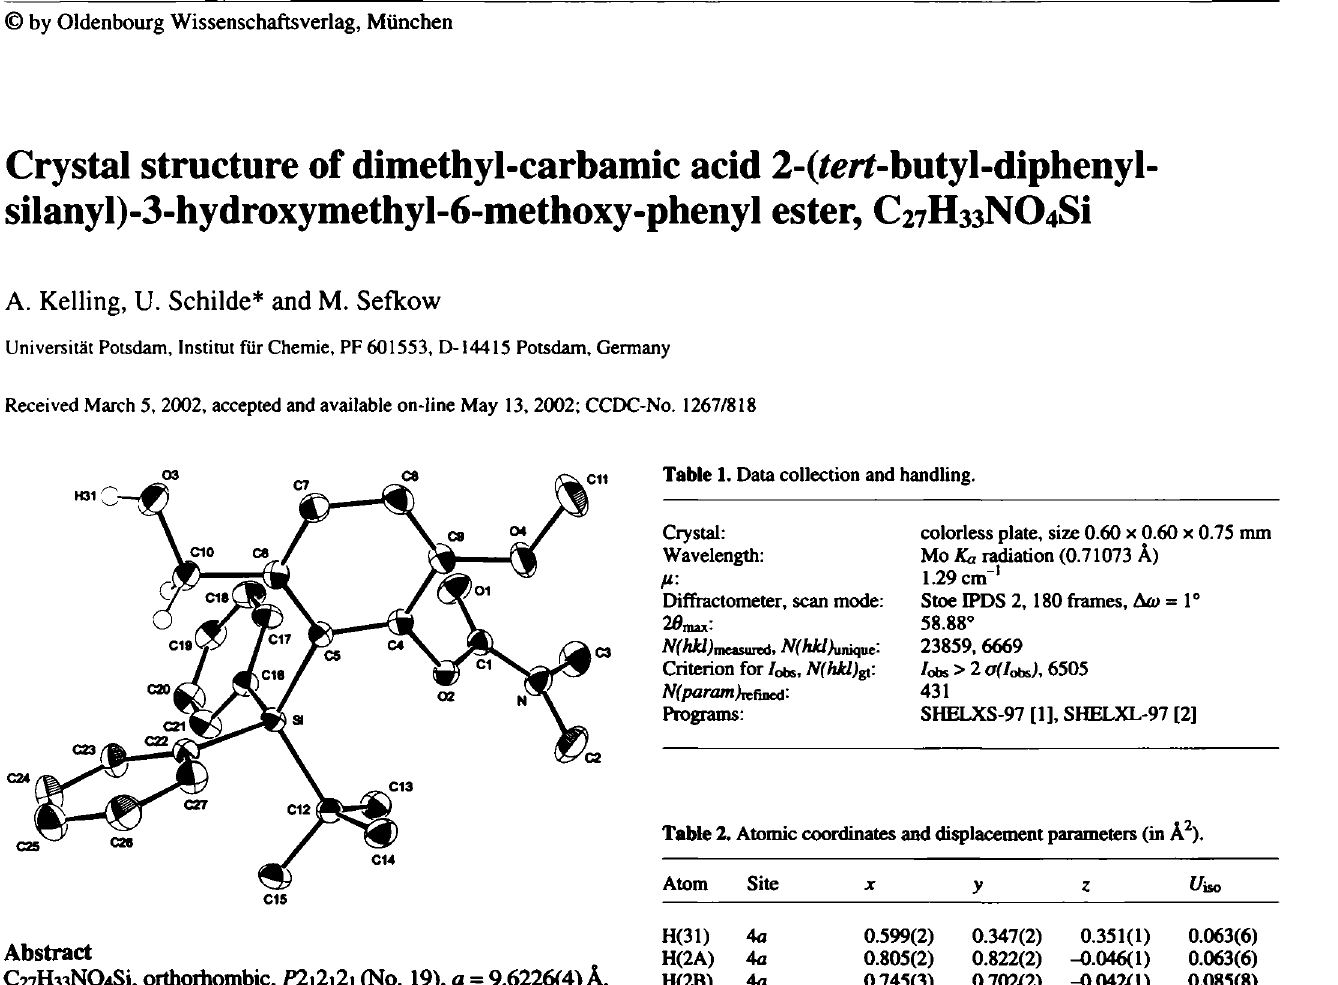
Table 2. Atomic coordinates and displacement parameters (in À 2